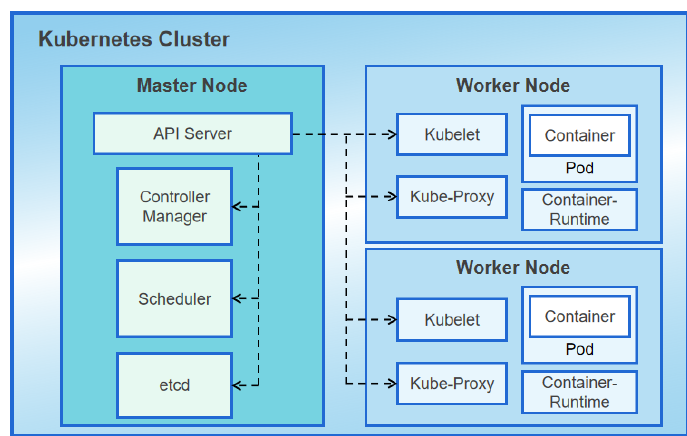
Figure 3. Kubernetes cluster